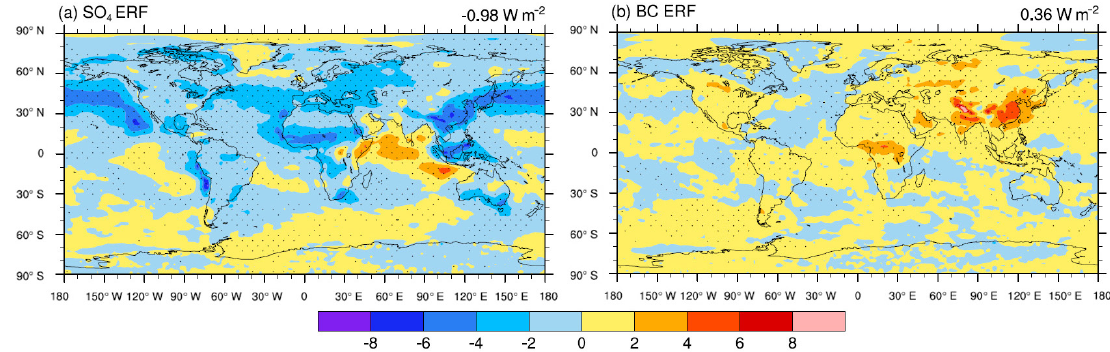
Figure 2. Annual mean distributions of (a) SO 4 and (b) BC ERF from PI to PD (unit: Wm − 2 ) . ERF is defined as the perturbation of net radiative flux at the TOA caused by aerosols. The dots represent significance at ≥ 95% confidence level from the t test.